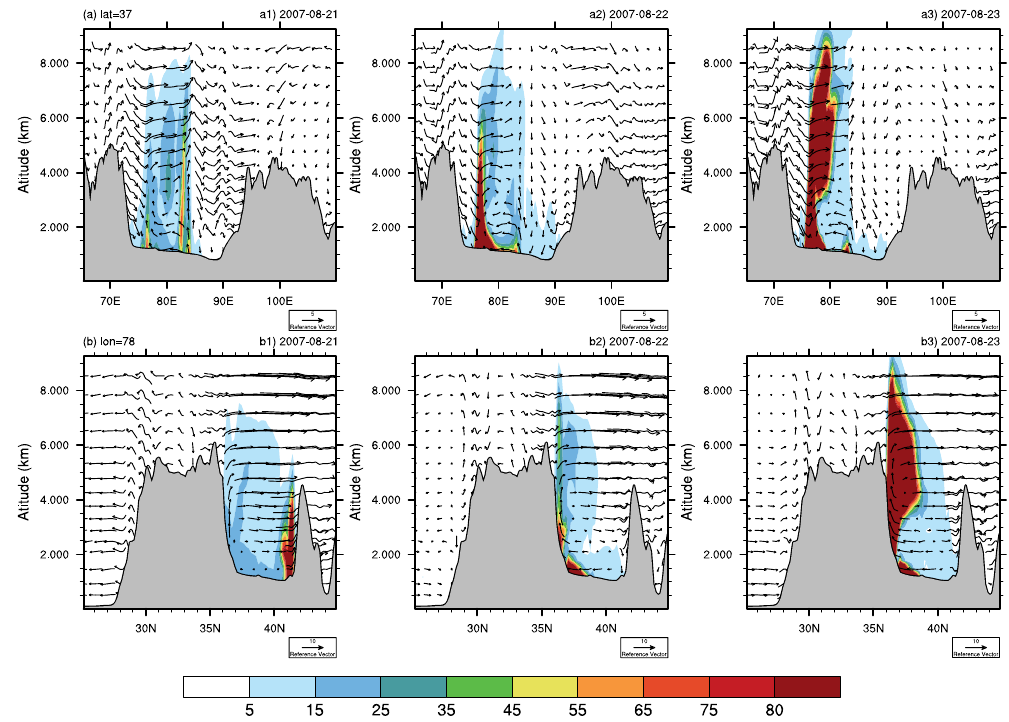
Figure 8. Cross-section of the (a) vertical-longitude and (b) vertical-latitude distributions of the simulated dust mass concentration (units: µgm − 3 ) and wind vectors (shown in arrows; the vertical velocity is multiplied by 10 and 30 for panels (a) and (b) , respectively) from 21 to 23 August 2007. The gray shading indicates the topography.